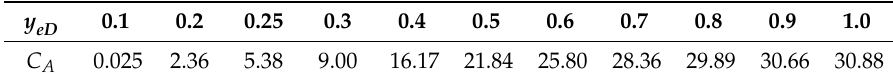
Table A1. Dietz shape factors for a range of aspect ratios.